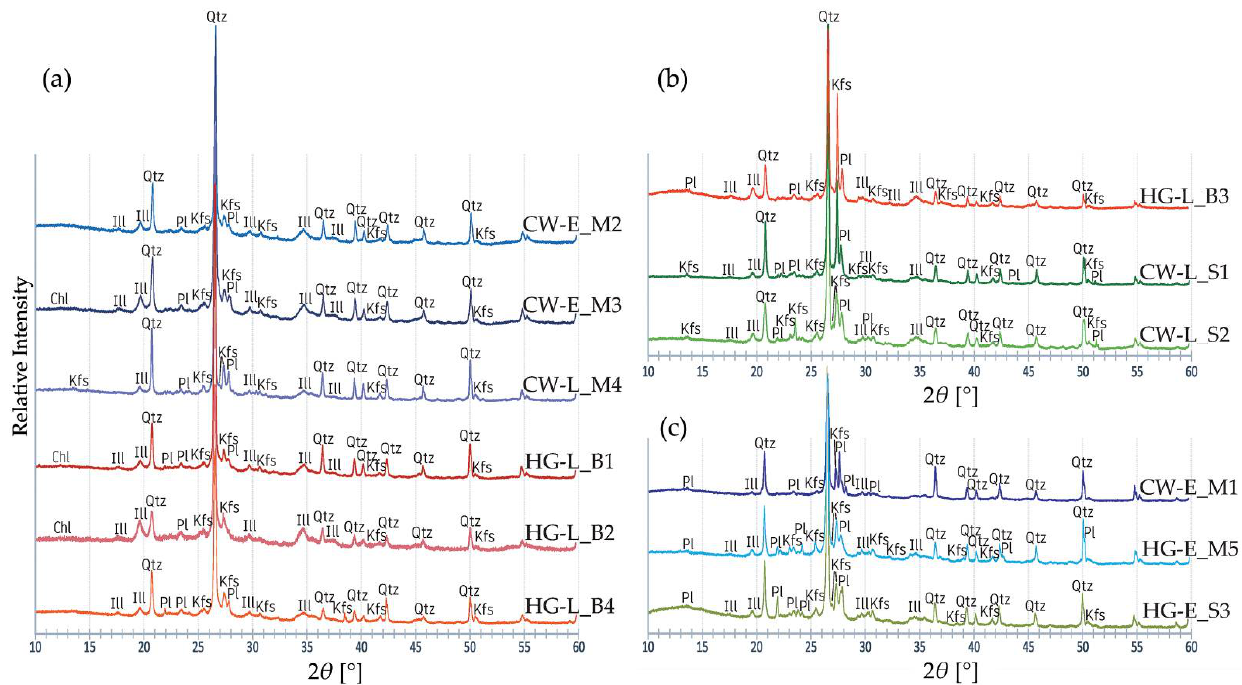
Figure 10. Diffractograms for the ceramic materials in the studied samples: ( a ) illite-rich; ( b ) alkali feldspar-rich; ( c ) plagioclase-rich. Blue diffractograms–samples from the Margiai settlement; green–samples from the Šakės settlement; red-orange–samples from the Barzdis settlement.